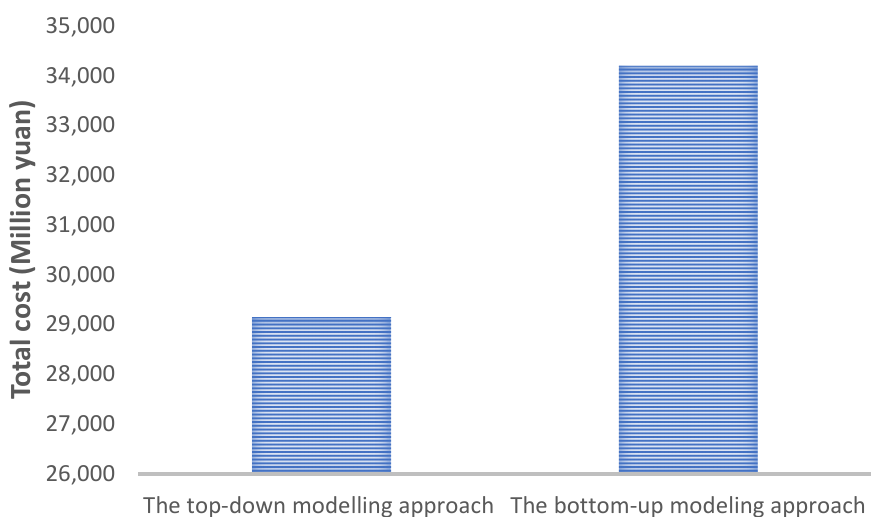
Figure 8. Comparison of the two modeling approaches.